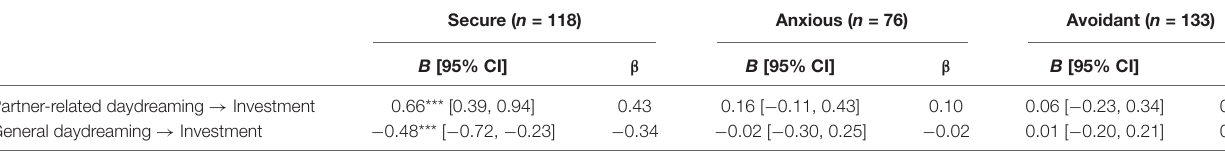
TABLE 5 | Cross-lagged effects from social daydreaming and general daydreaming to investment per attachment style. Secure ( n =